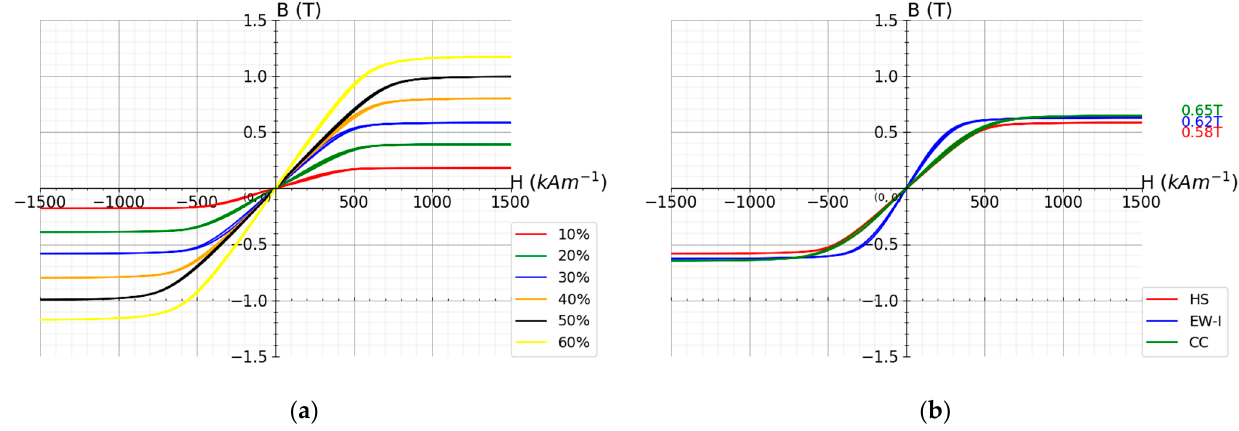
Figure 7. The magnetization loop for ( a ) STL type styrene-ethylene-butadiene-styrene thermoplastic elastomers with HS filler content between 10 and 60 vol.-%, ( b ) 30 vol.-% filler content of three different CIP grades in STL type styrene-ethylene-butadiene-styrene thermoplastic elastomers.